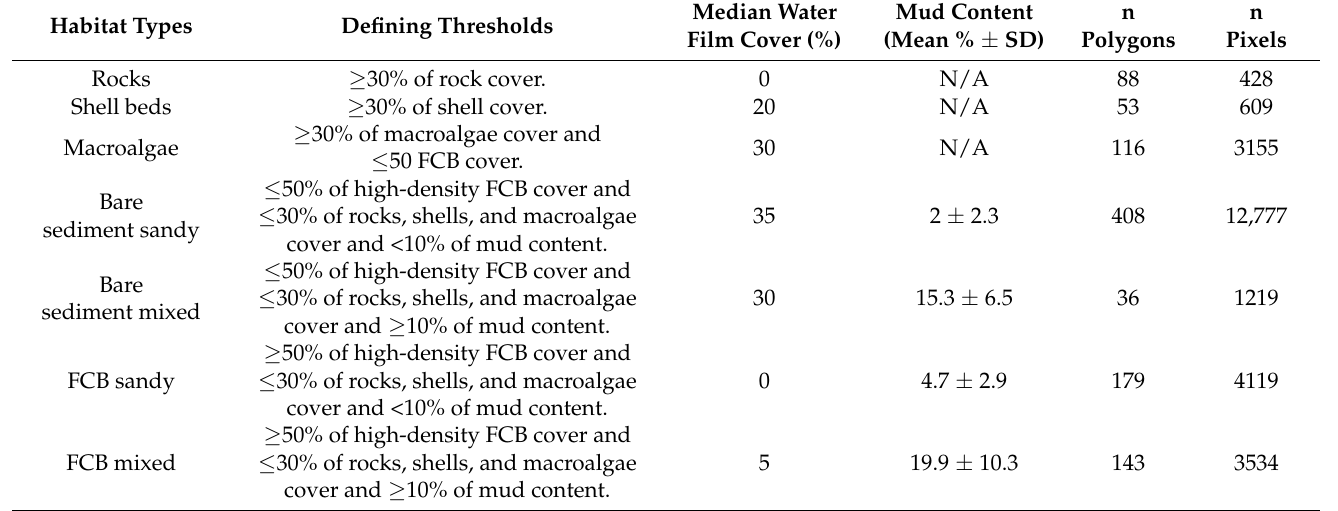
Table 2. Habitat types defined for the supervised classifications of intertidal habitats, with a descrip- tion of the defining thresholds and features (from the field reference data and sediment analysis) and sample sizes (polygons and pixels). Mud content is the percentage weight of sediment <63 µ m. FCB: fiddler crab burrow